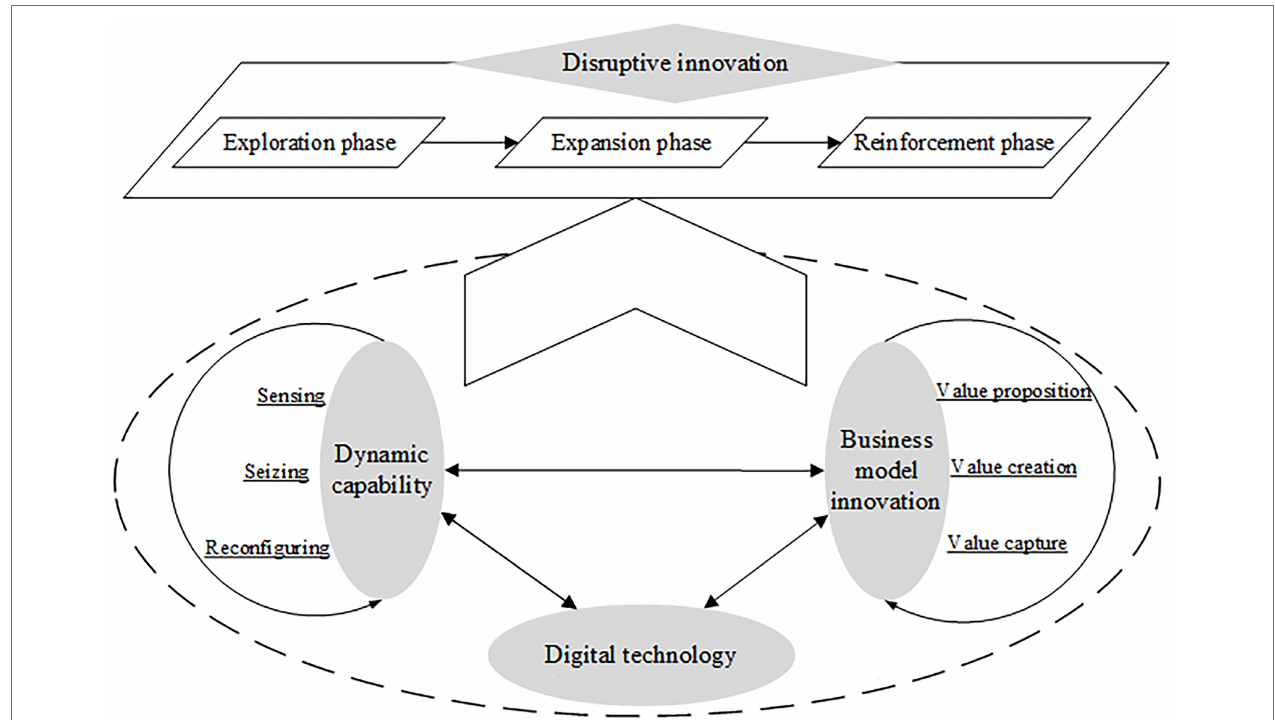
FIGURE 5 | The conceptual model of start-up disruptive innovation path in the digital